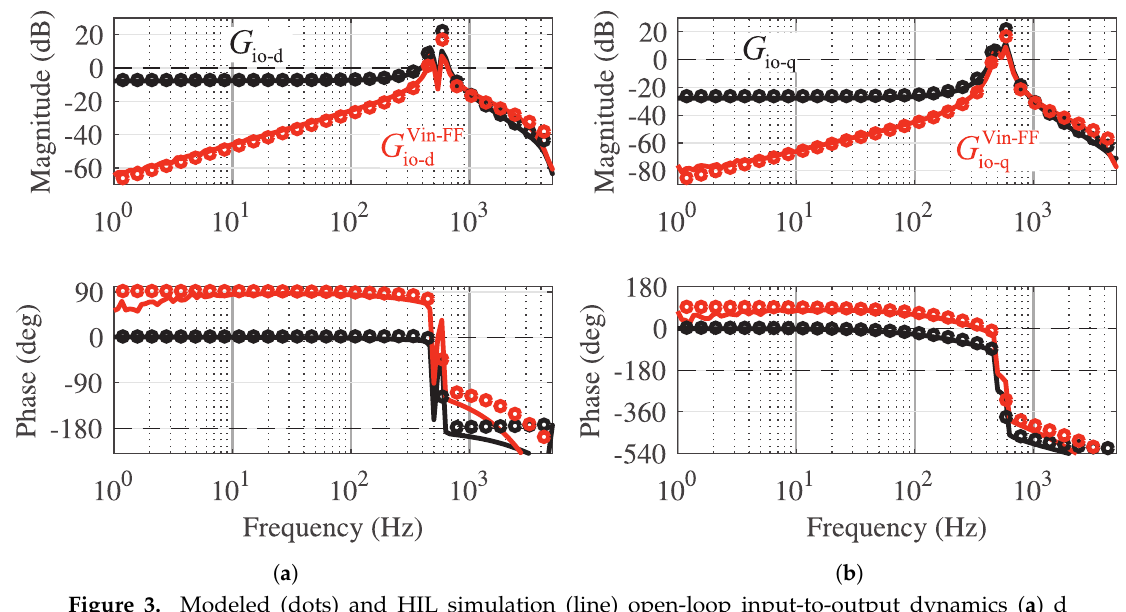
Figure 3. Modeled (dots) and HIL simulation (line) open-loop input-to-output dynamics ( a ) d component and ( b ) q component.